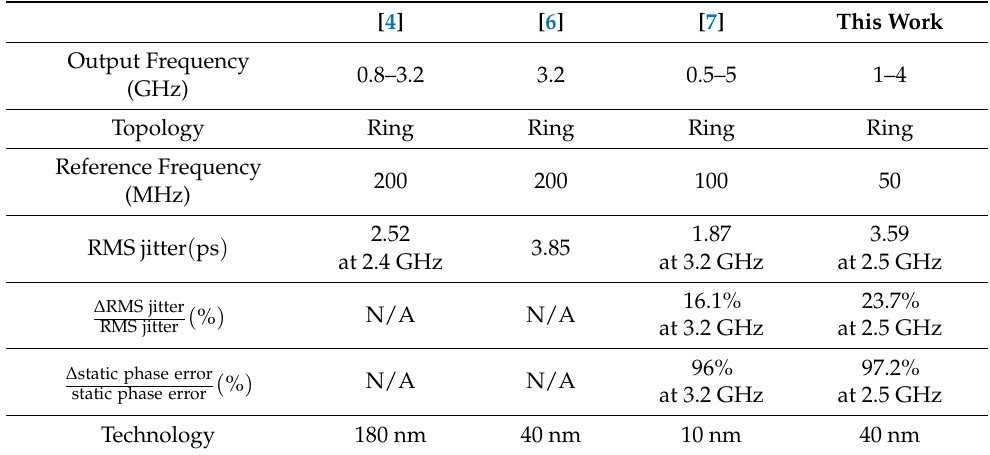
Table 1. Summary and